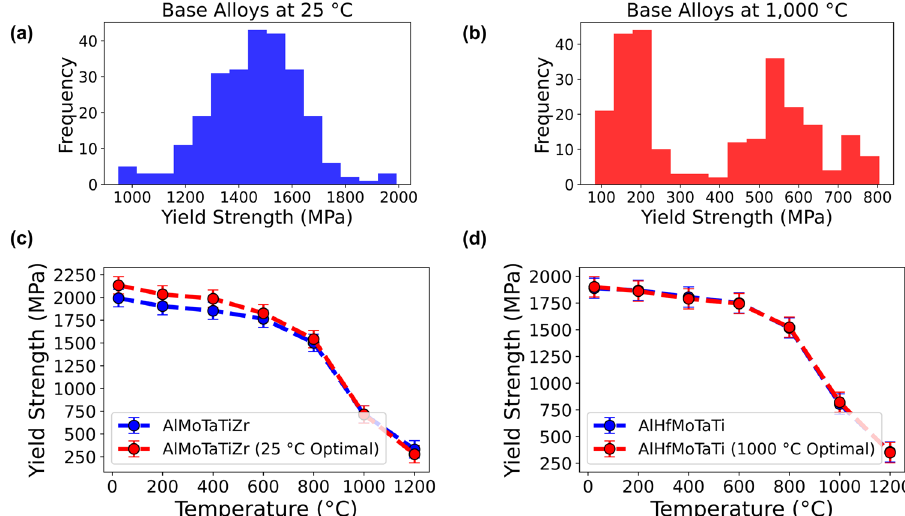
Fig. 7 Yield strength predictions of 252 fi ve-element equiatomic base alloys. a Distribution of yield strength at 25 °C for the fi ve-element equiatomic alloys. b Distribution of yields strength at 1000 °C. c AlMoTaTiZr and Al 0.239 Mo 0.123 Ta 0.095 Ti 0.342 Zr 0.201 (optimized for 25 °C). Yield strength improved by 7%. d AlHfMoTaTi and Al 0.151 Hf 0.236 Mo 0.137 Ta 0.131 Ti 0.345 (optimized for 1000 °C). Yield strength improved by 2%. A 95% con fi dence level error (±94 MPa) is shown for